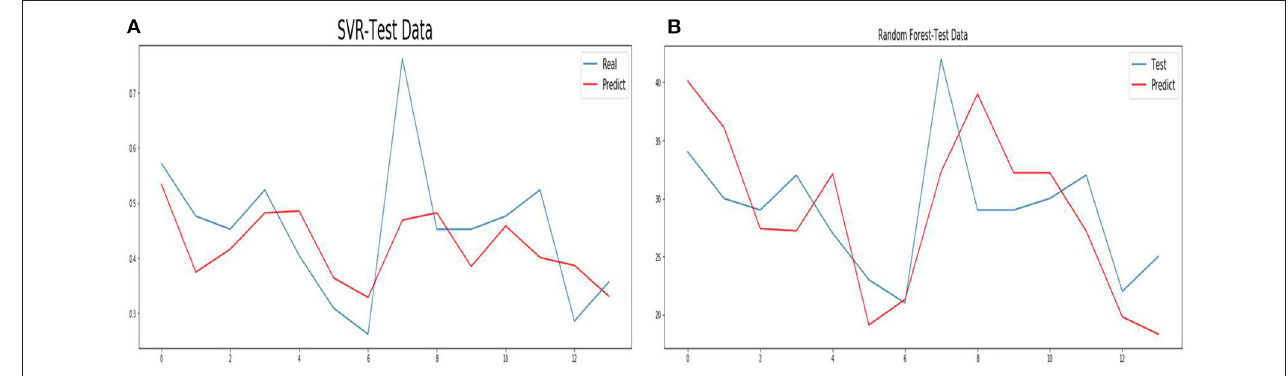
FIGURE 10 | Forecasts from SVR (A) and Random Forest (B) .